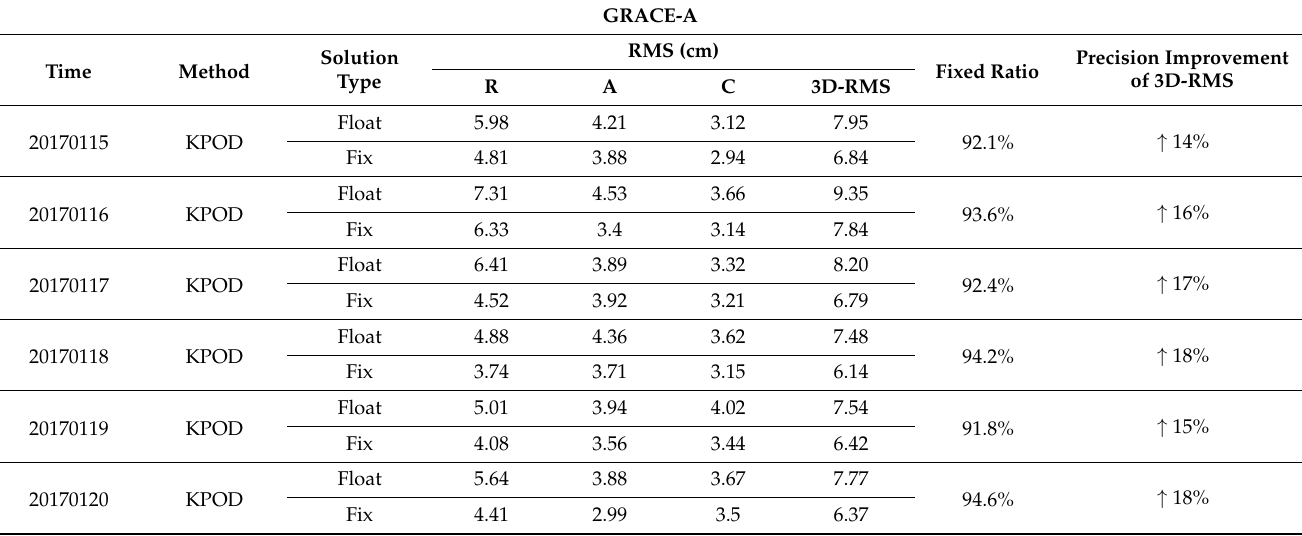
Table 4. The GRACE-A ambiguity-fixed ratio and RMS of real-time KPOD in R (radial), A (along- track), an C (cross-track) directions and 3D-RMS (total position error) with different solution